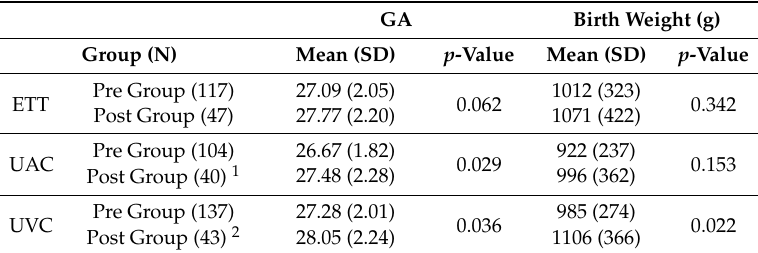
Table 1. Infant gestational age and birth weight in pre and post education